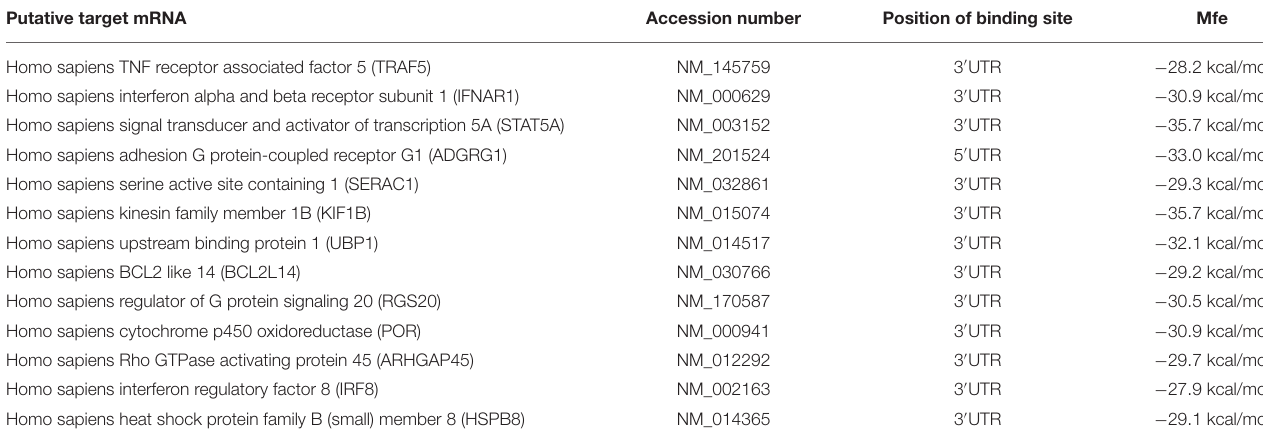
TABLE 1 | Putative hcmv-miR-US33as-5p targets identified by RNA hybrid. Putative target